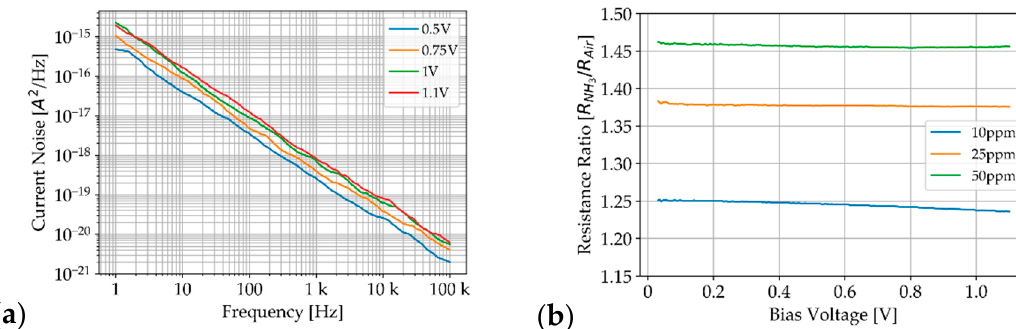
Figure 1. ( a ) Voltage noise power spectral density (PSD) for different bias voltages in air at 22 °C, 35% RH. ( b ) Sensor resistance variation with bias voltage for the different ammonia gas concentrations referenced to clean air.